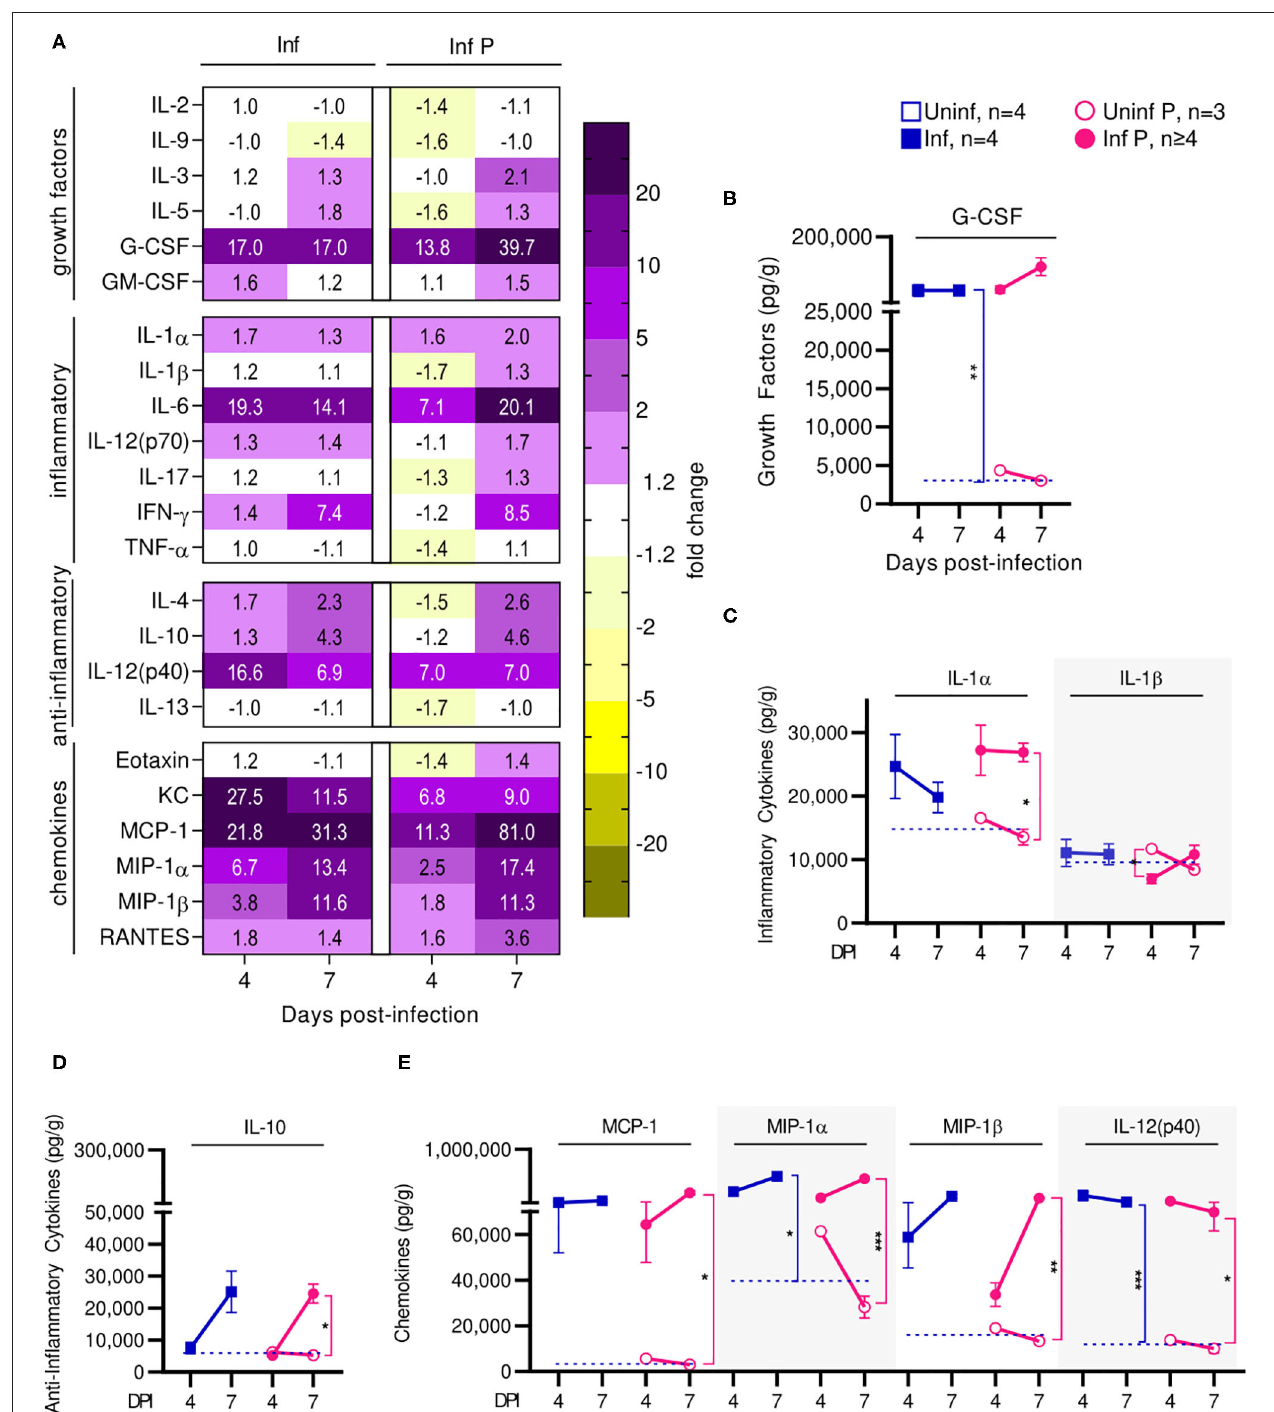
FIGURE 4 | Pregnant females show delayed lung inflammation following influenza infection. (A) Lung protein concentrations from infected non-pregnant and pregnant mice from 4 and 7 DPI were quantified for growth factors, inflammatory and anti-inflammatory cytokines and chemokines. Values within the heat-map denote mean fold change over uninfected controls. Fold change was transformed as follows to aid in visualization of decreases: if fold change > 1, no transformation; if fold change < 1, –(10 | log10fold change |). Concentrations of the growth factor (B) G-CSF, inflammatory cytokines (C) IL-1 α and IL-1 β , and regulatory cytokine (D) IL-10 were quantified. (E) Chemokines MCP-1, MIP-1 α , MIP-1 β , and IL-12(p40) were also quantified at 4 and 7 DPI. Cytokine quantitation was analyzed via Two-way ANOVA and post-hoc multiple T-tests without assuming consistent SD with correction for multiple comparisons by controlling the false discovery rate per the two-stage set up method of Benjamini Krieger and Yekutieli (Q = 5%). Blue dashed horizontal lines indicate the average value of uninfected non-pregnant control animals. * p < 0.05; ** p < 0.01; *** p < 0.001.